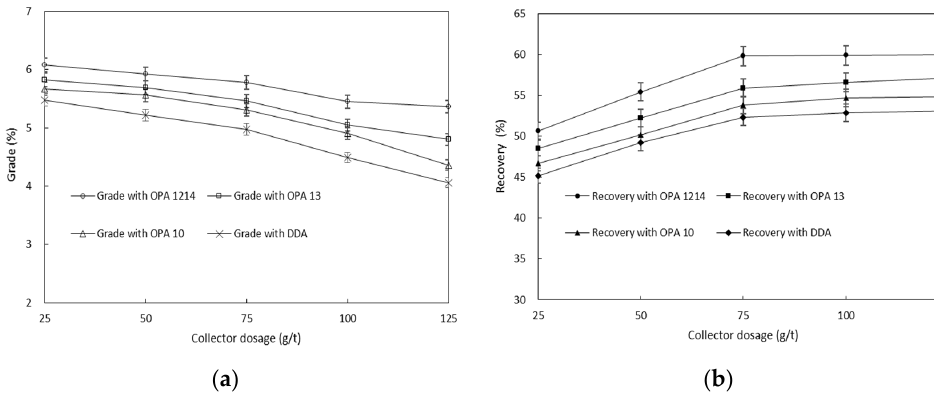
Figure 4. Effect of collector concentration on the concentrate Zn grade ( a ) and recovery ( b ).